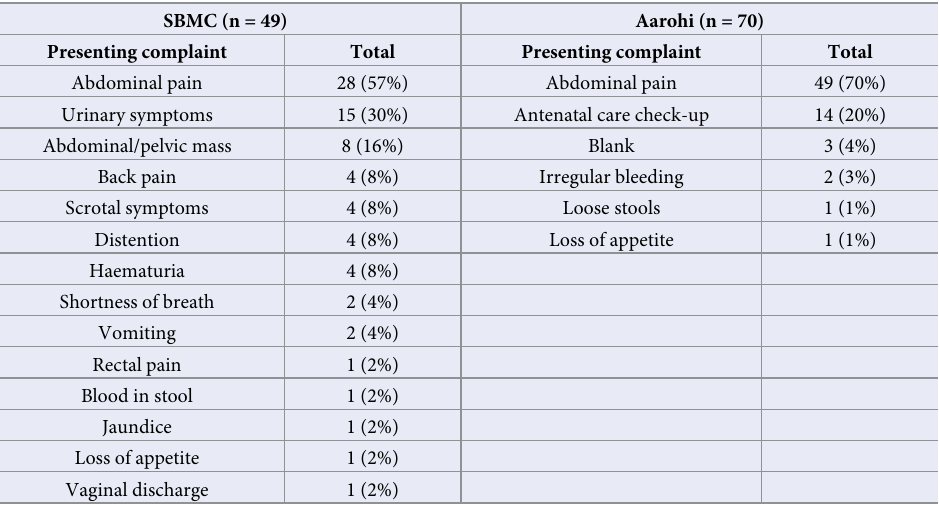
Table 2. Data from SBMC � and Aarohi �� on abdominal presentations.